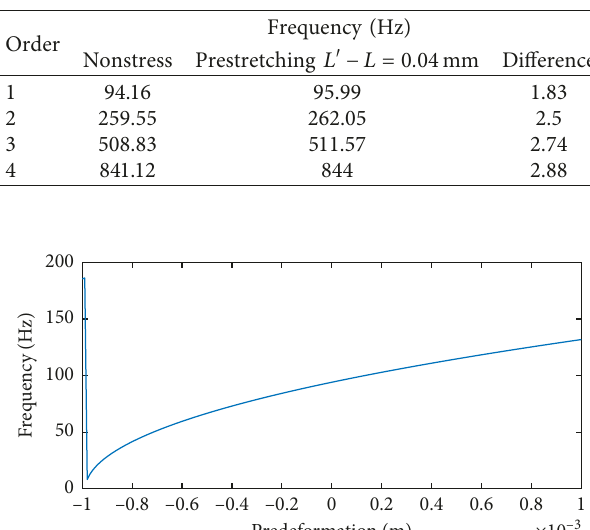
Figure 3: The test results of the beam under different axial tensile forces (solid line: frequency response function; dotted line: coherence function). (a) F 265N. (b) F 505 N. (c) F 775N. (d) F 1005N. (cid:31) (cid:31) (cid:31) (cid:31) Table 3: Natural frequencies of ball screw with